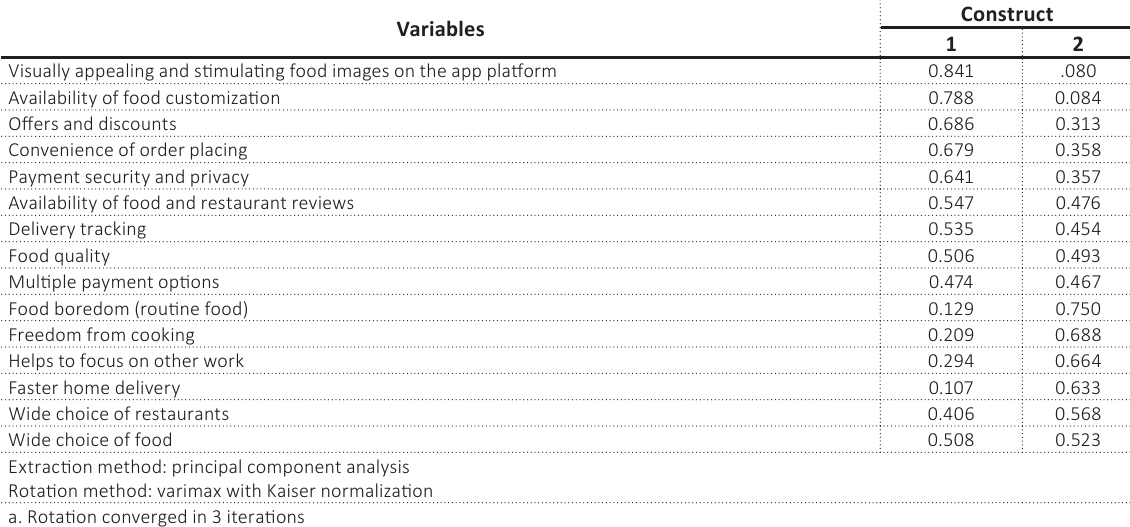
Table 9. Rotated component